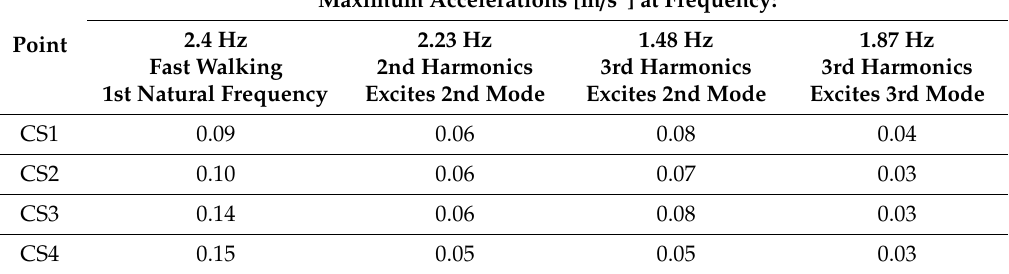
Table 7. Maximum vertical accelerations generated by a single pedestrian walking obtained at the representative points of the cable-stayed footbridge with the RC slab for the selected frequencies. Maximum Accelerations [m / s 2 ] at Frequency: 2.4 Point